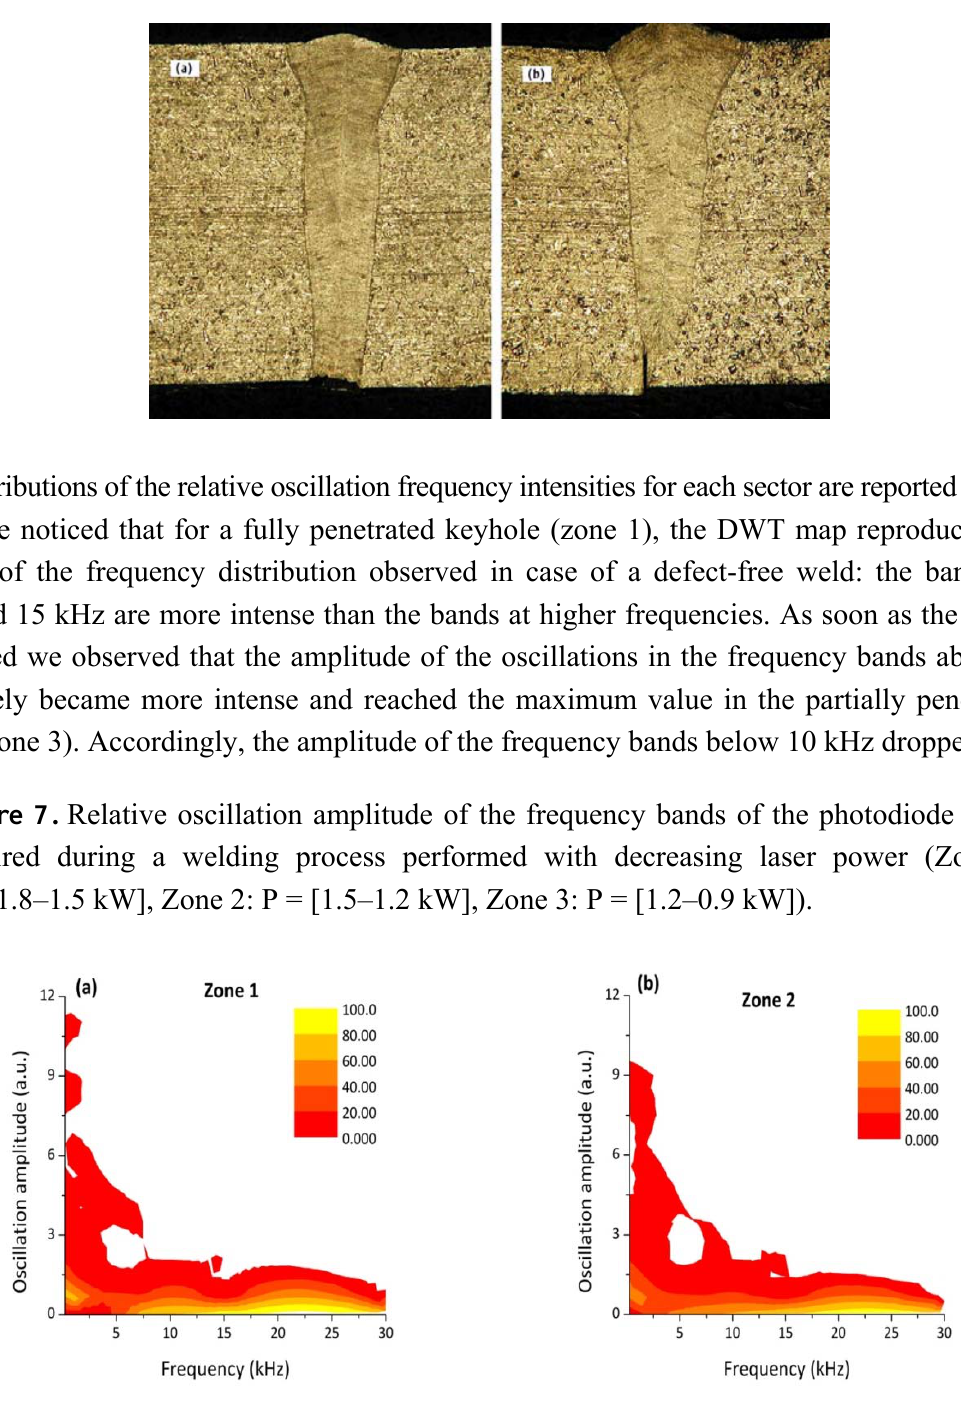
Figure 6. Macrographs of the joint cross sections: (a) full penetration: P = 1.8 kW, v = 80 mm/s, Q = 100 L/min (zone 1); (b) partial penetration: P = 1.0 kW, v = 80 mm/s, He Q = 100 L/min (zone 3). He